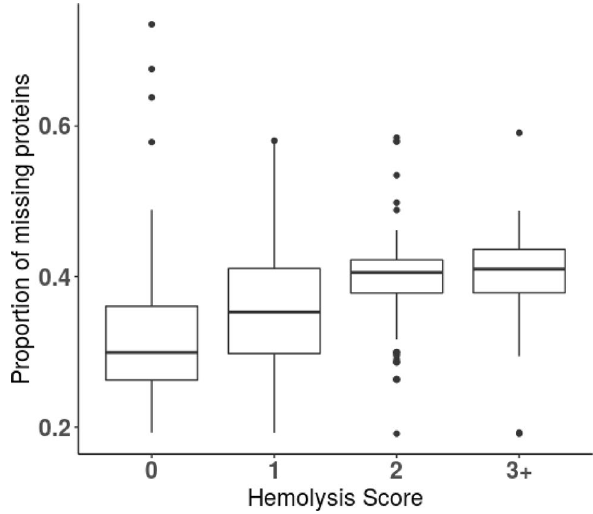
Figure 3. Boxplots visualizing relative proportion of missing proteins. Missing proteins were determined by comparing total number of proteins identified across all samples of each type, and number of proteins